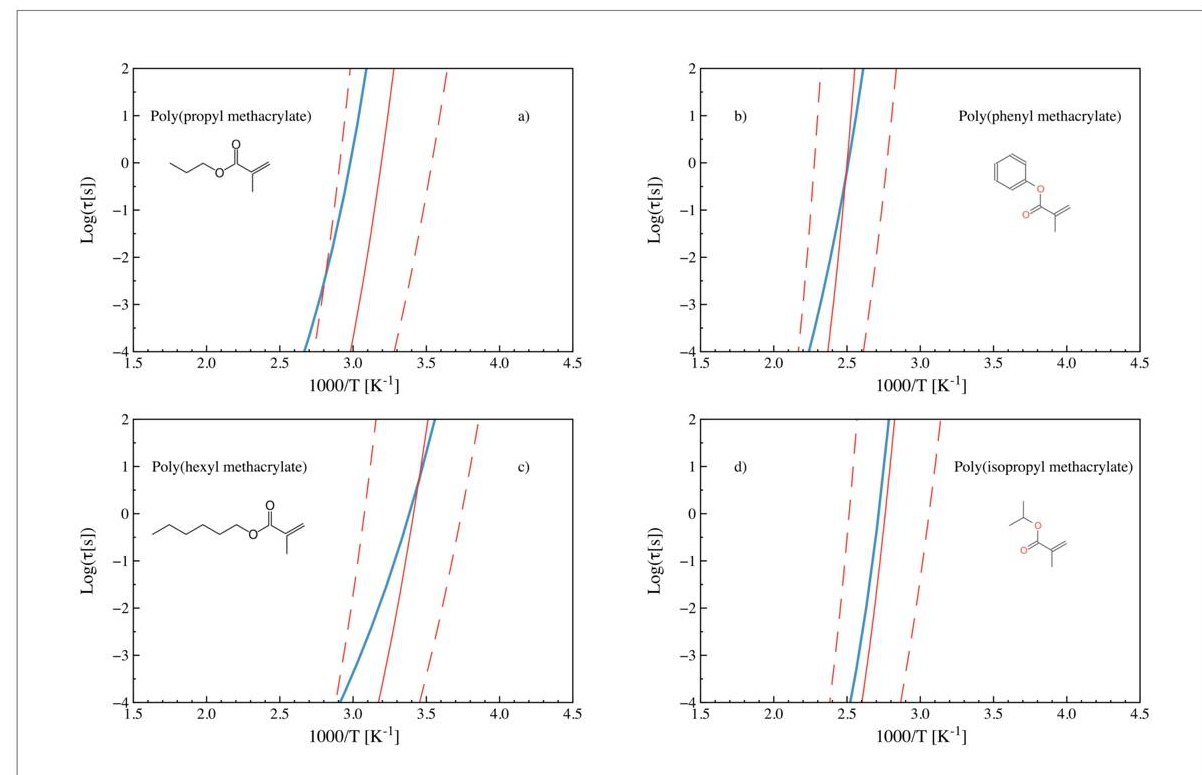
Figure 3. Experimental (blue) and predicted (red) relaxation times (obtained from ECNLE theory) vs. 1000/T. Dashed lines stand for the confidence interval corresponding to the typical deviation in the ANN prediction (10% relative error): ( a ) Poly (propyl methacrylate) [28], ( b ) poly (phenyl methacrylate) [30], ( c ) poly (hexyl methacrylate) [27], and ( d ) poly (isopropyl methacrylate) [30].